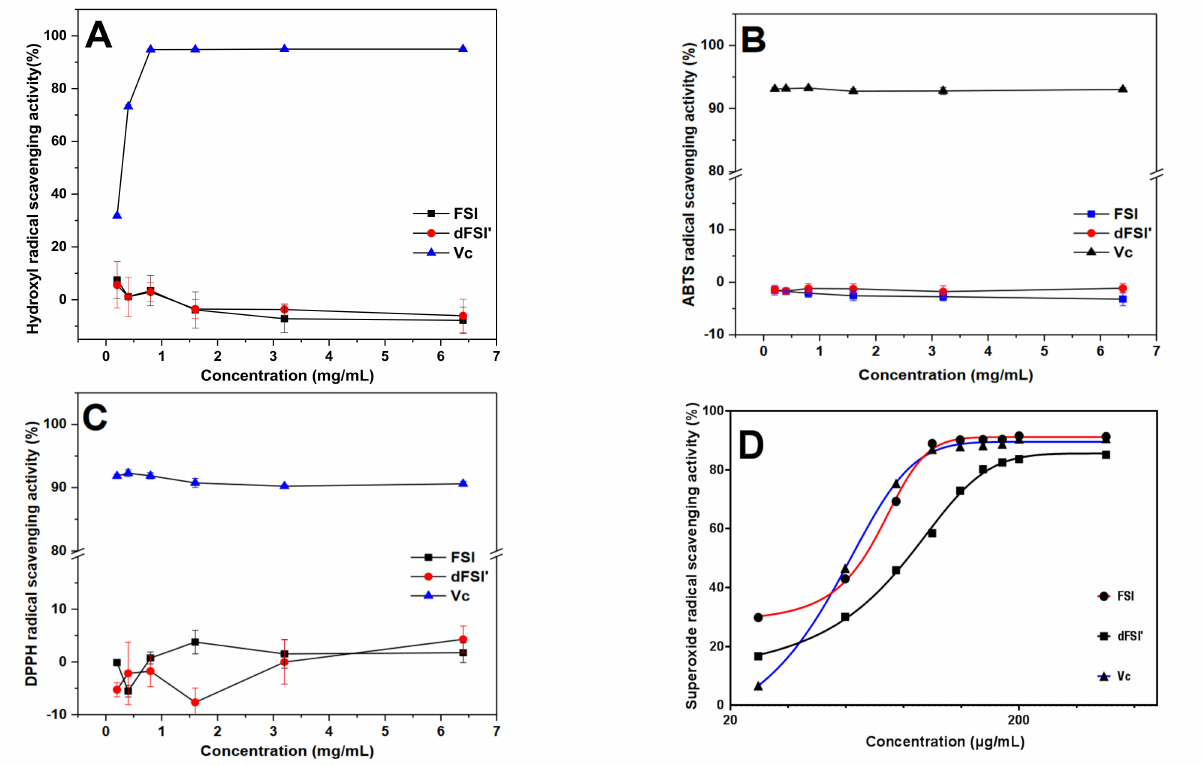
Figure 7. Scavenging effect of FSI and dFSI (cid:48) on hydroxyl radicals ( A ), ABTS radicals ( B ), DPPH radicals ( C ) and superoxide radicals ( D ), respectively. ( n =